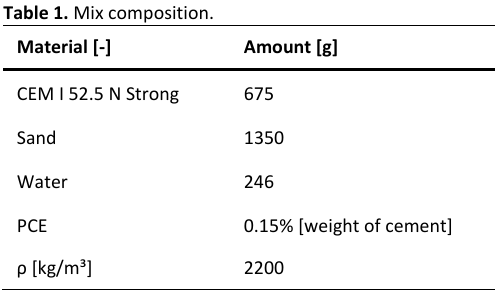
Table 1. Mix composition.